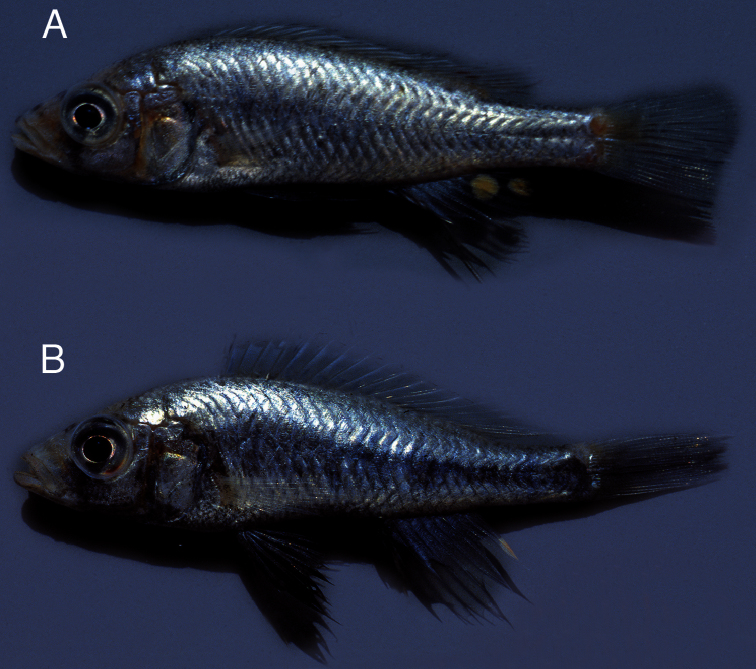
Live colours of Haplochromis goldschmidti sp. n. A sexually active ♂, 53.6 mm SL (paratype, RMNH.PISC.80480) B sexually active ♂, 57.5 mm SL (paratype, RMNH.PISC.83575).